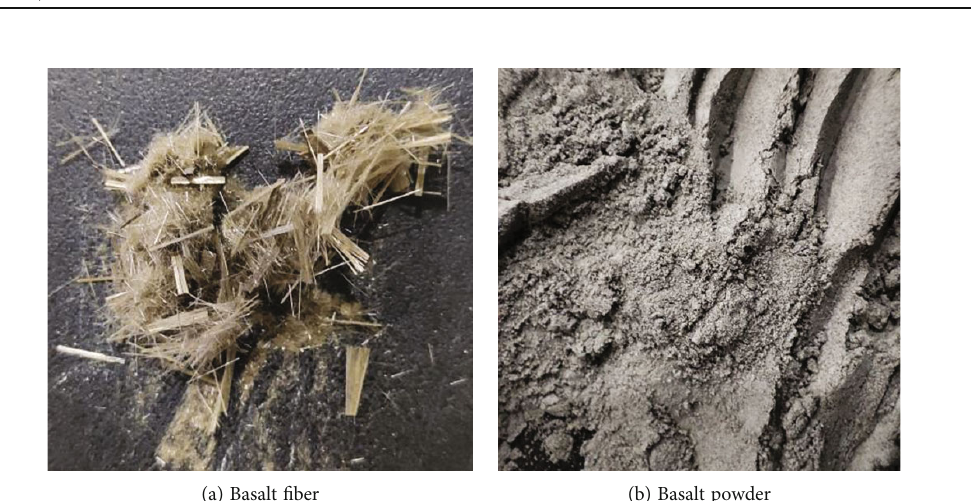
Figure 2: Modi fi ed materials.